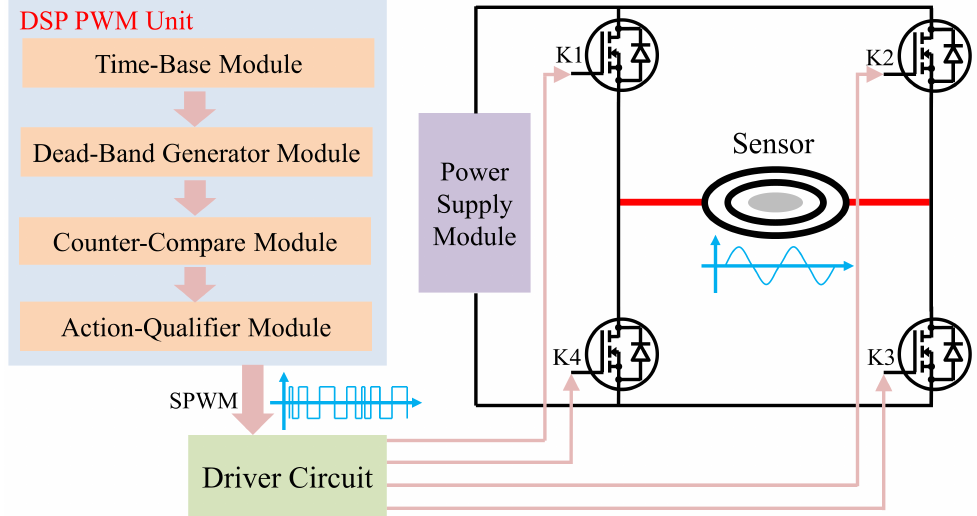
Figure 7. Structure diagram of the transmitting